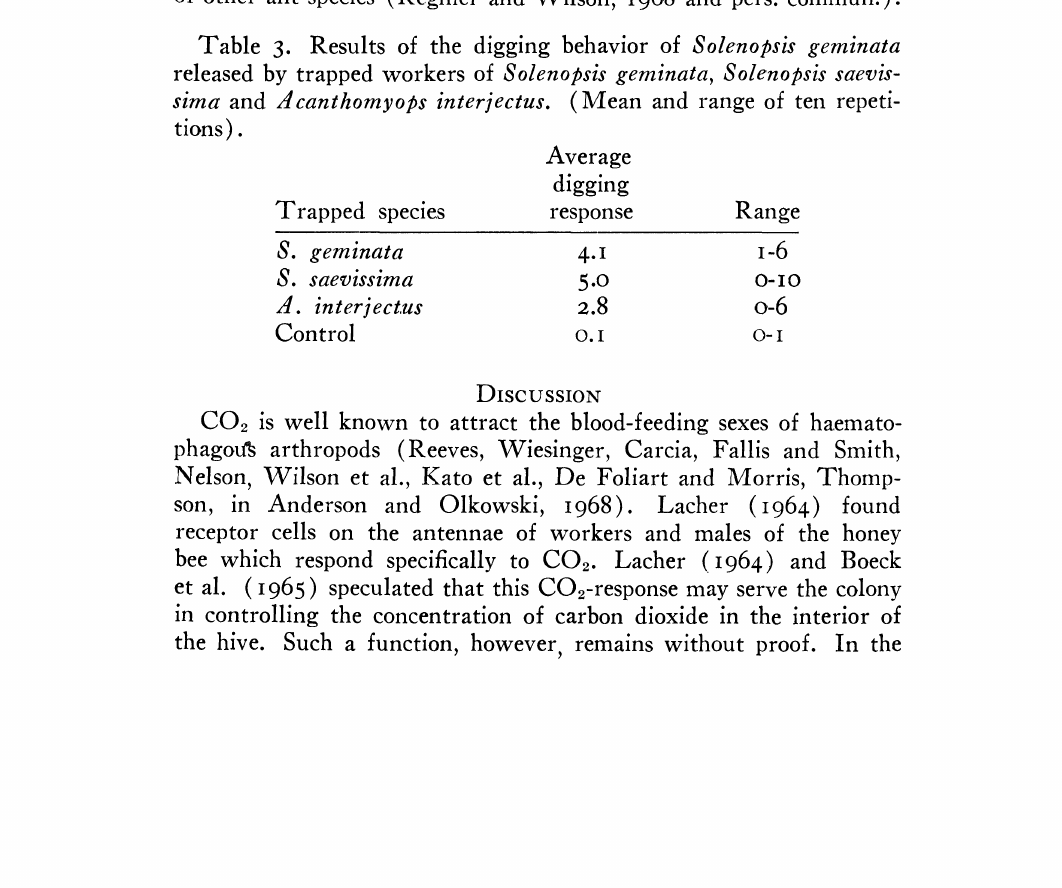
Table 3. Results of the digging behavior o1: Solenopsis geminata released by trapped workers of Solenopsis geminata, Sole’nopsis saevis- sima and A canthomyops interjectus. (Mean and range o1: ten repeti-